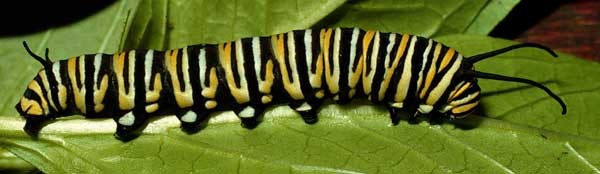
Danaus
plexippus voucher n. 98-SRNP-7073, feeding on Asclepiadaceae. Image voucher n. DHJ46548.jpg